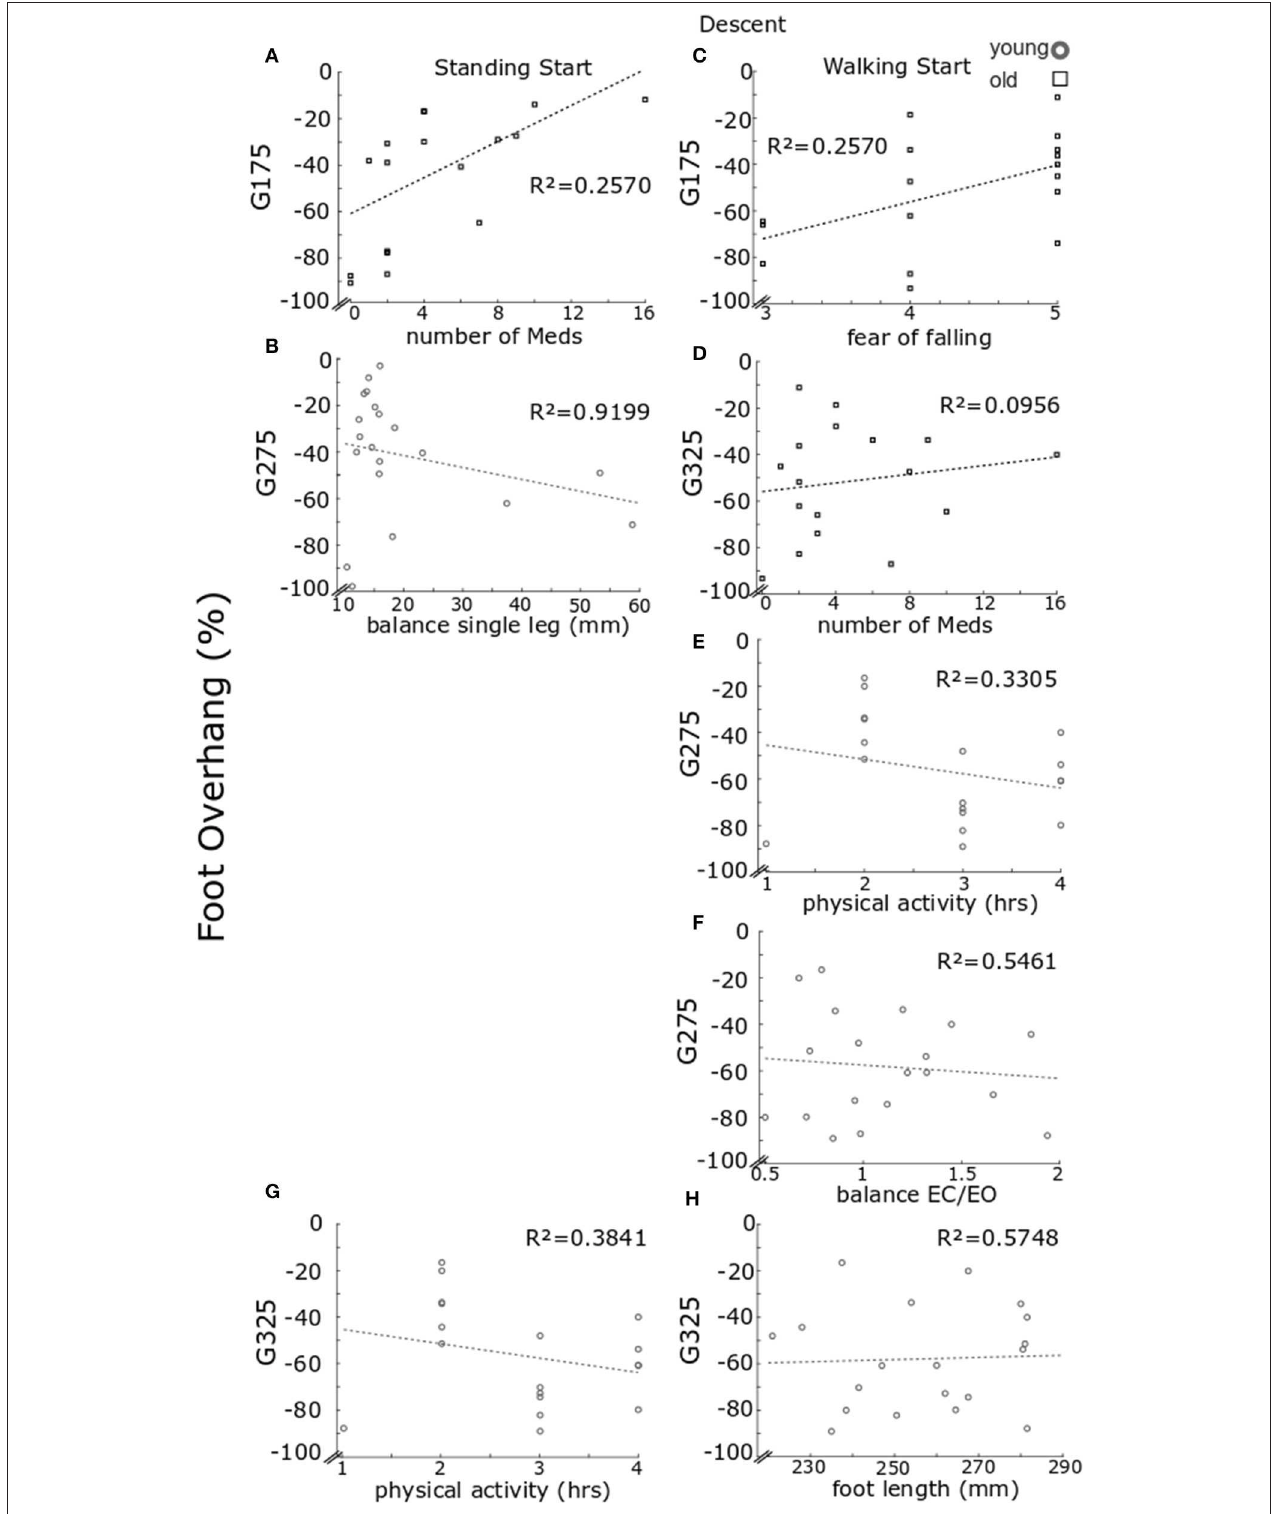
FIGURE 10 | Regression model results for foot overhang in descent. Regression model results for foot overhang. Each panel reports individual data for older (black) and younger (gray) participants. Results are reported for standing start (A–B) and walking start (C–H) . Standing start. Overhang for going of 175mm for older participants relative to number of medications taken (A) and for younger participants at goings of 275mm relative to balance on one leg (B) . Walking start.